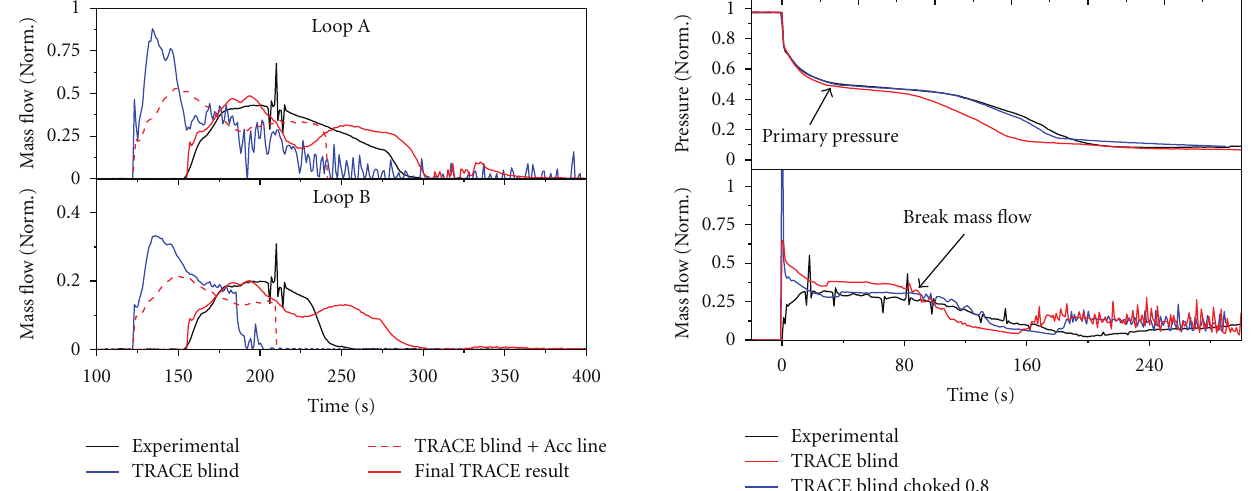
Figure 14: Primary pressure and break mass flow for Test 1, pretest results with di ff erent two-phase break discharge coe ffi